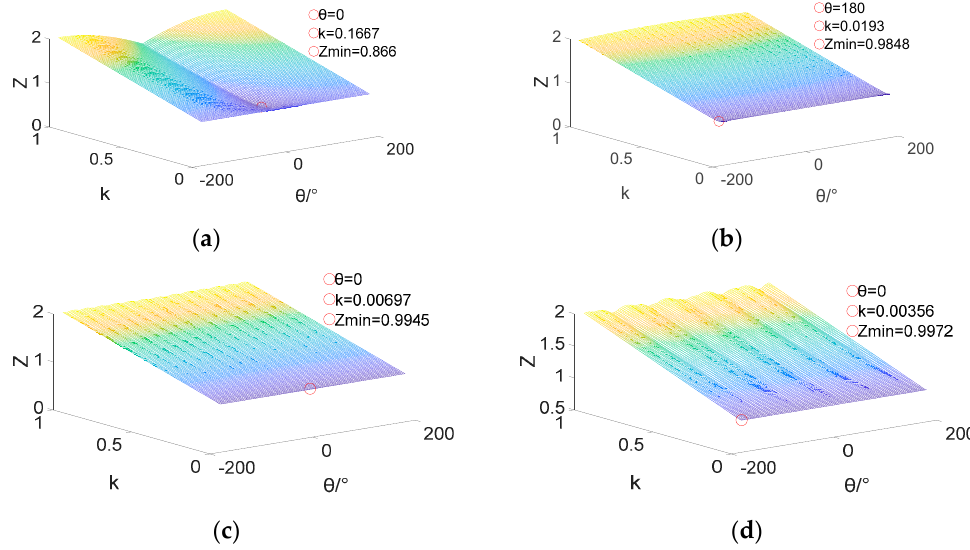
Figure 5. Distribution of waveform amplitude under single-component zero-order harmonics ( a ) 3rd harmonic; ( b ) 9th harmonic; ( c ) 15th harmonic; ( d ) 21st harmonic.